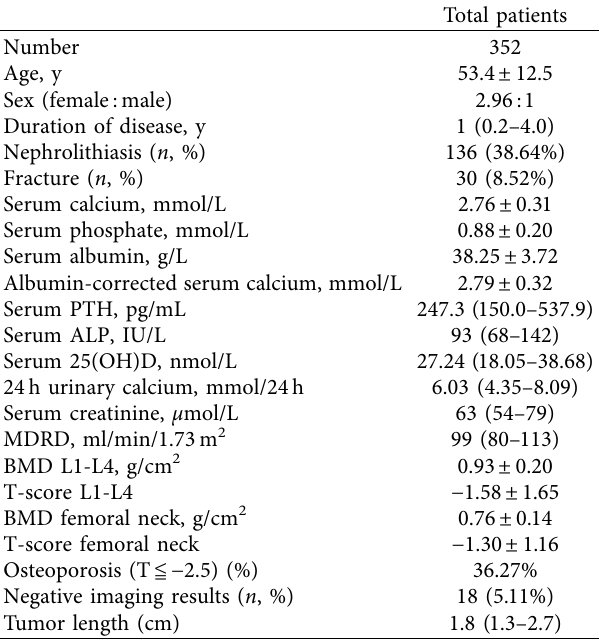
Table 1: Clinical features and laboratory test results in PHPT